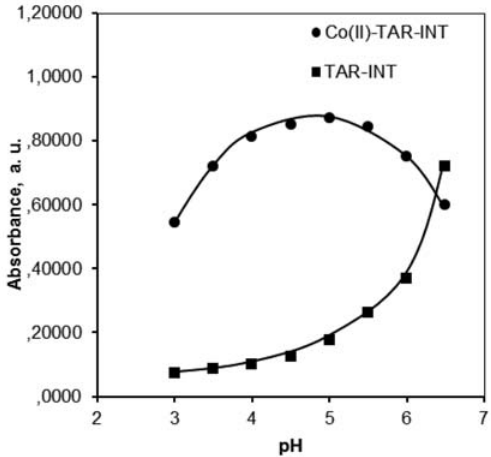
tio 1:2:1. Figure 2. Absorbance of Co–TAR–INT extract against TAR-INT